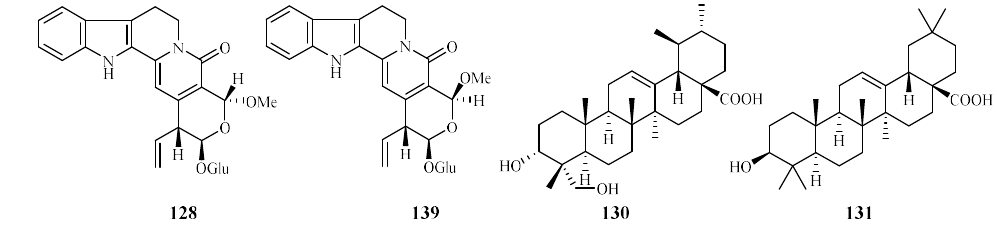
Figure 29. Compounds from a Rubiaceae plant.